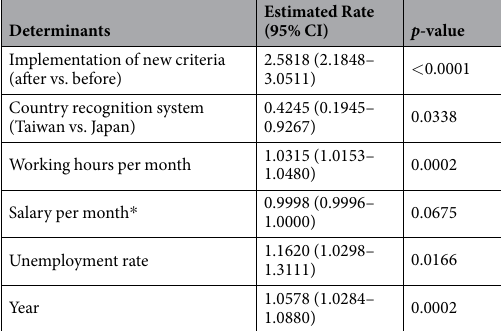
Table 6. Estimated marginal effects of determinants on rates of overwork-related cardiovascular and cerebrovascular diseases. The estimate intercepts are 2.1381 × 10 − 5 (95% CI = 1.9139 × 10 − 6 to 2.3886 × 10 − 4 , p -value < 0.0001). * Based on average annual exchange rate and adjusted for Consumer Price Index 18–21